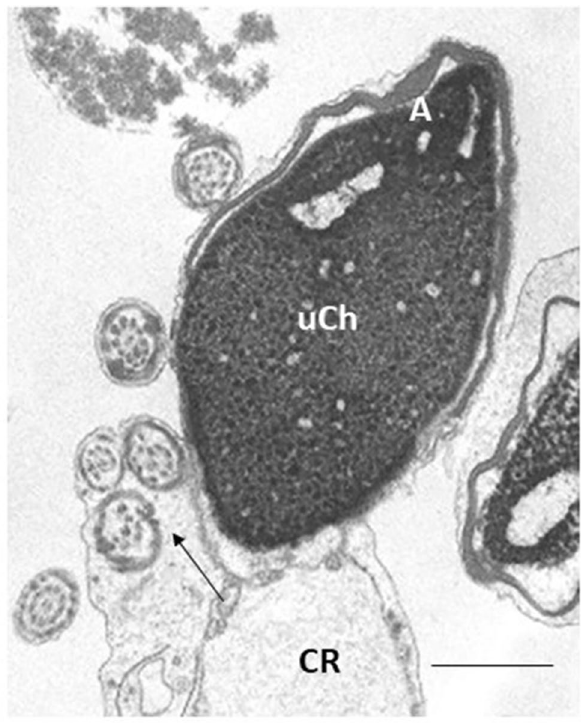
Figure 2. TEM micrograph of longitudinal section of an immature sperm. The acrosome (A) is anomalous in shape and the altered nucleus shows uncondensed chromatin (uCh). A cytoplasmic residue (CR) embedding the coiled tail with altered axonemal and periaxonemal structures (arrow) is present. Bar: 1